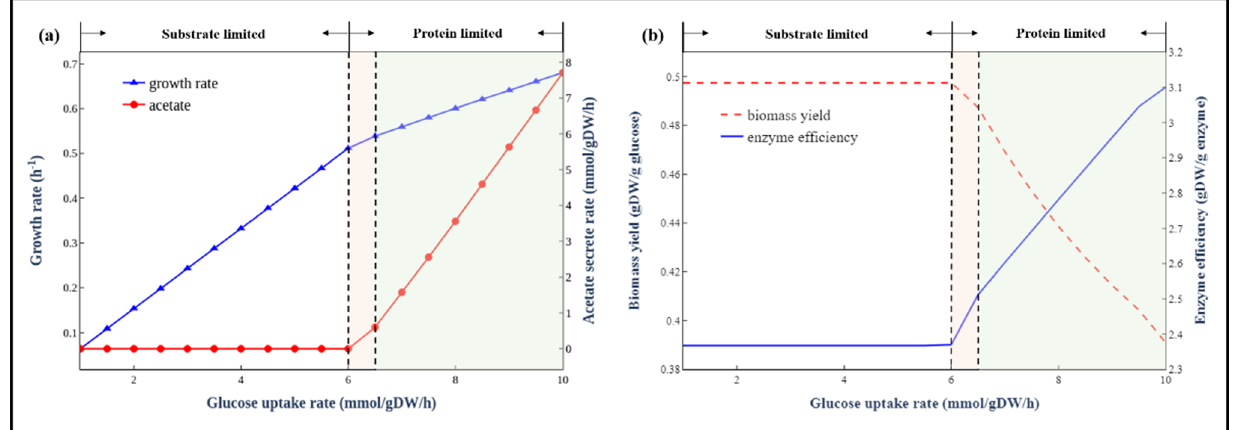
Figure 5. The metabolic behaviours of E. coli at different glucose uptake rates. ( a ) Simulated growth rates at different glucose uptake rates. ( b ) The trade-off between biomass yield and enzyme efficiency.